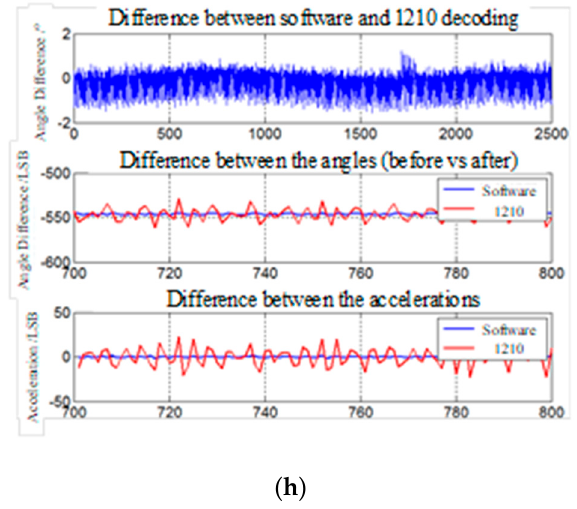
Figure 11. Comparing waveforms of software decoding angle and hardware decoding angle at different speeds: ( a ) 10 rpm experimental waveforms; ( b ) 50 rpm experimental waveforms; ( c ) 1000 rpm experimental waveforms; ( d ) 2000 rpm experimental waveforms; ( e ) 4000 rpm experimental waveforms; ( f ) 6000 rpm experimental waveforms; ( g ) 8000 rpm experimental waveforms; ( h ) 10,000 rpm experimental waveforms.